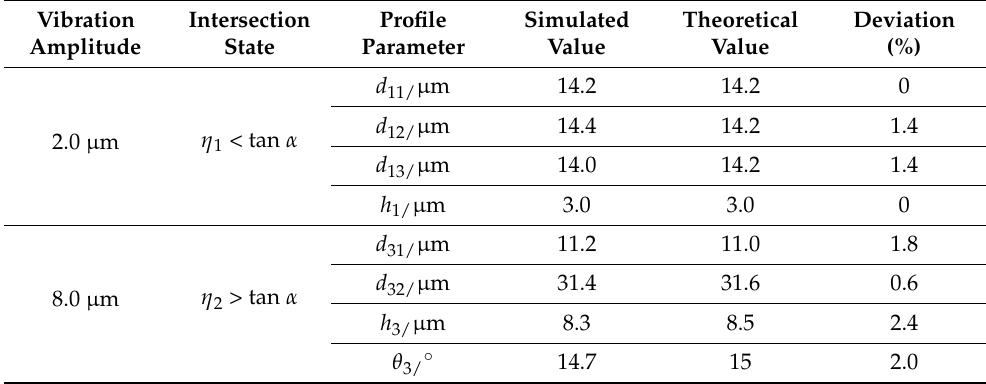
Table 3. Comparison of simulated and theoretical values of dimple profiles, under vibration ampli- tudes of 2.0 and 8.0 µ m.